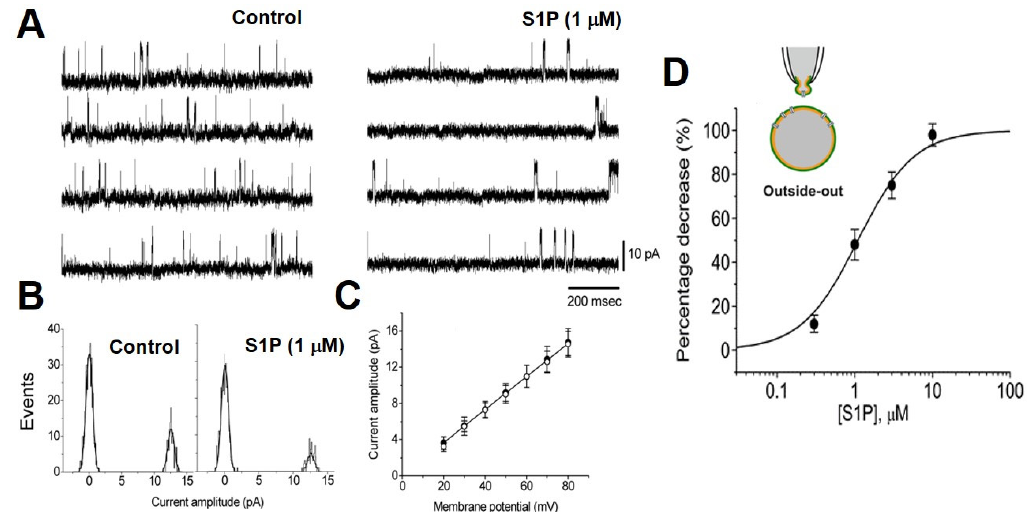
Figure 1. Effects of sphingosine-1-phosphate (S1P) on BK Ca activities in outside-out patches. ( A ) Original traces in the control (left) and after the application of S1P (1 µ M, right) in the bath. The pipette was filled with a high K + solution with 0.1 µ M Ca 2+ , the cells were bathed in a high-K + bathing solution with 1.8 mM CaCl 2 , holding at +60 mV. ( B ) Amplitude histograms of BK Ca obtained in the absence (left) and presence (right) of S1P. Data were fitted by Gaussian distributions with the maximum likelihood method. ( C ) Averaged I-V relations of BK Ca obtained in the absence ( ● ) and presence ( ○ ) of S1P. Each point represents the mean ± SEM ( n = 6 − 8). The single-channel conductance between the control and S1P is identical. ( D ) The dose-response relationship for S1P-induced inhibition of BK Ca . The IC 50 value, maximally inhibitory percentage, and Hill coefficient were 1.1 µM, 100%, and 1.2, respectively. Each point represents the mean ± SEM ( n = 4 − 9, in five cultures).